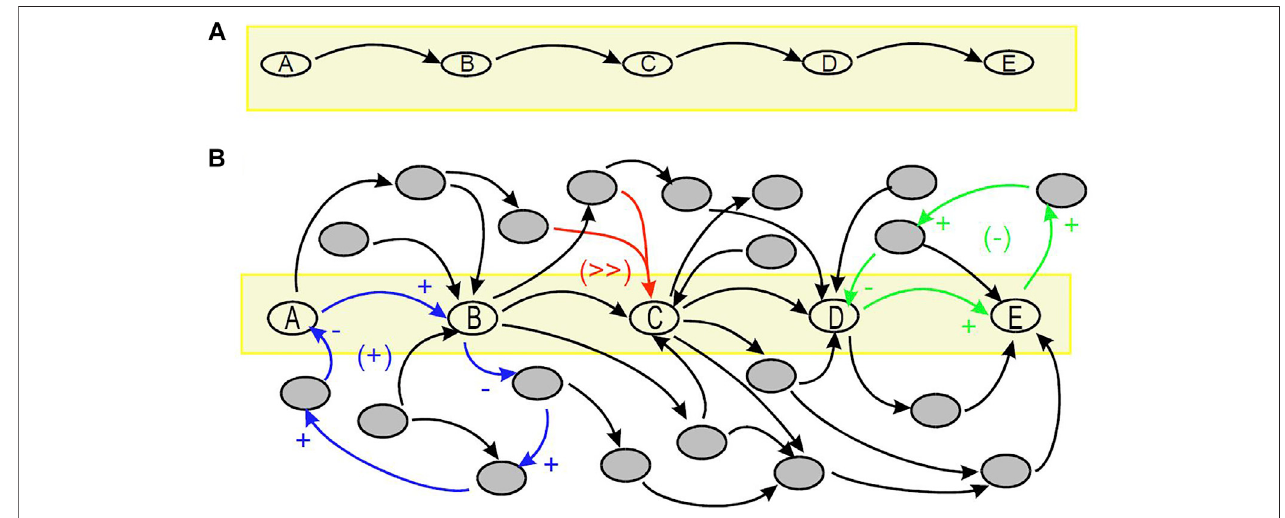
FIGURE 4 | (A) A simpli fi ed notion of cause – effect chains: A causes B causes C, etc.; (B) a more realistic description of complex cause — effect webs with synergistic effects ( >> ), positive (+) and negative ( − ) feedback mechanisms (Cassel-Gintz,